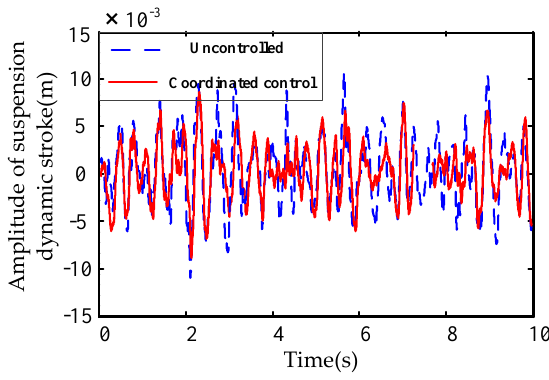
Figure 23. Vehicle pitch angle under the straight condition.